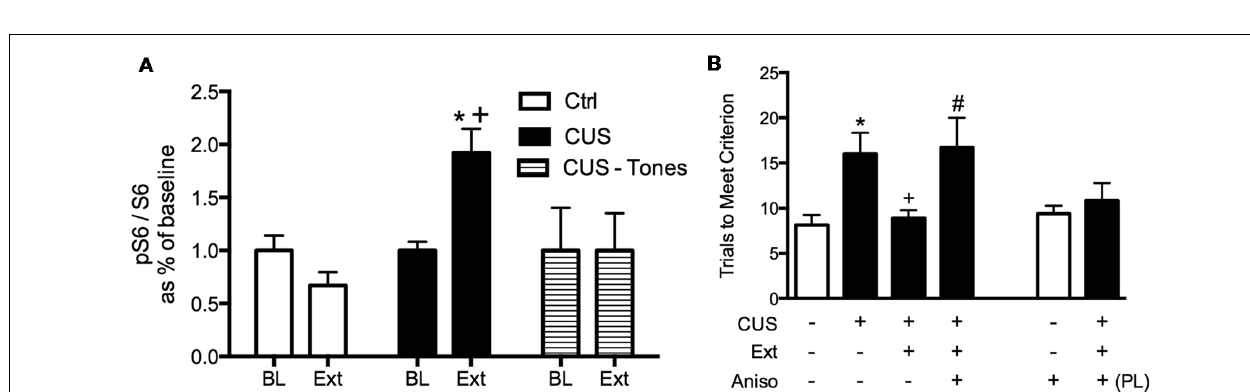
FIGURE 4 | Therapeutic effects of extinction after CUS require protein synthesis in the IL medial prefrontal cortex (mPFC). (A) Extinction induced a significant increase in phosphorylation of ribosomal protein S6, reflecting initiation of de novo protein synthesis in the mPFC of CUS-treated rats ( ∗ p < 0.05, Extinction compared to Baseline), but not in unstressed controls, nor in CUS-tone control rats exposed to tone presentations but without prior fear conditioning ( + p < 0.05, CUS Extinction compared to unstressed Extinction and to CUS tone controls); n = 4–6 per group. (B) Inhibition of protein synthesis by microinjection of anisomycin (50 µ g/0.5 µ l) into the IL cortex prior to extinction prevented the rescue of cognitive set-shifting that had been compromised by CUS. Chronic stress induced a significant increase in trials to criterion (TTC) on the set-shifting task ( ∗ p < 0.05, CUS-tone control-vehicle compared to unstressed-tone control-vehicle). Extinction treatment reversed the effect of stress, restoring TTC to unstressed control levels ( + p < 0.05, CUS-extinction-vehicle compared to CUS-tone control-vehicle). Microinjection of anisomycin into IL cortex before extinction treatment prevented the beneficial effect of extinction on set-shifting compromised by CUS, as TTC were comparable to CUS tone controls ( # p < 0.05, CUS-extinction-anisomycin compared to CUS-extinction-vehicle); n = 6–8 per group. Administering anisomycin into the IL cortex of unstressed animals had no effect on set-shifting. Similarly, as a site-specificity control, administering anisomycin into the PL cortex of stressed animals prior to extinction did not prevent the therapeutic effect of extinction. Data expressed as mean ± SEM. Reproduced and adapted with permission from Fucich et al.